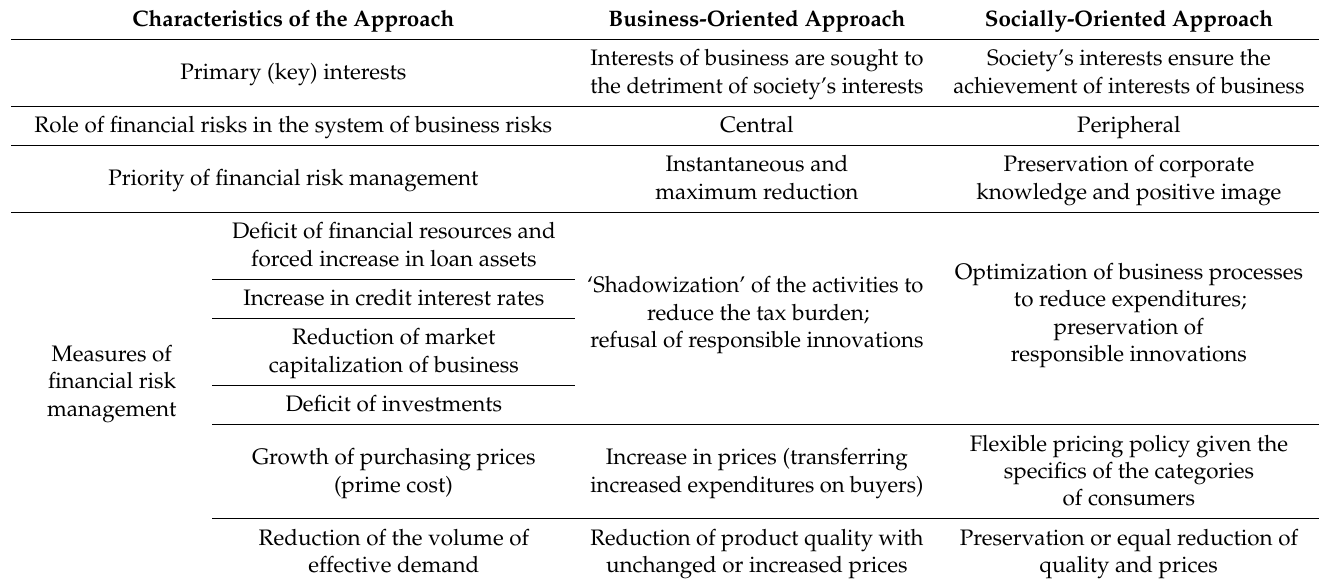
Table 7. Comparative characteristics of the alternative approaches to financial risk management in